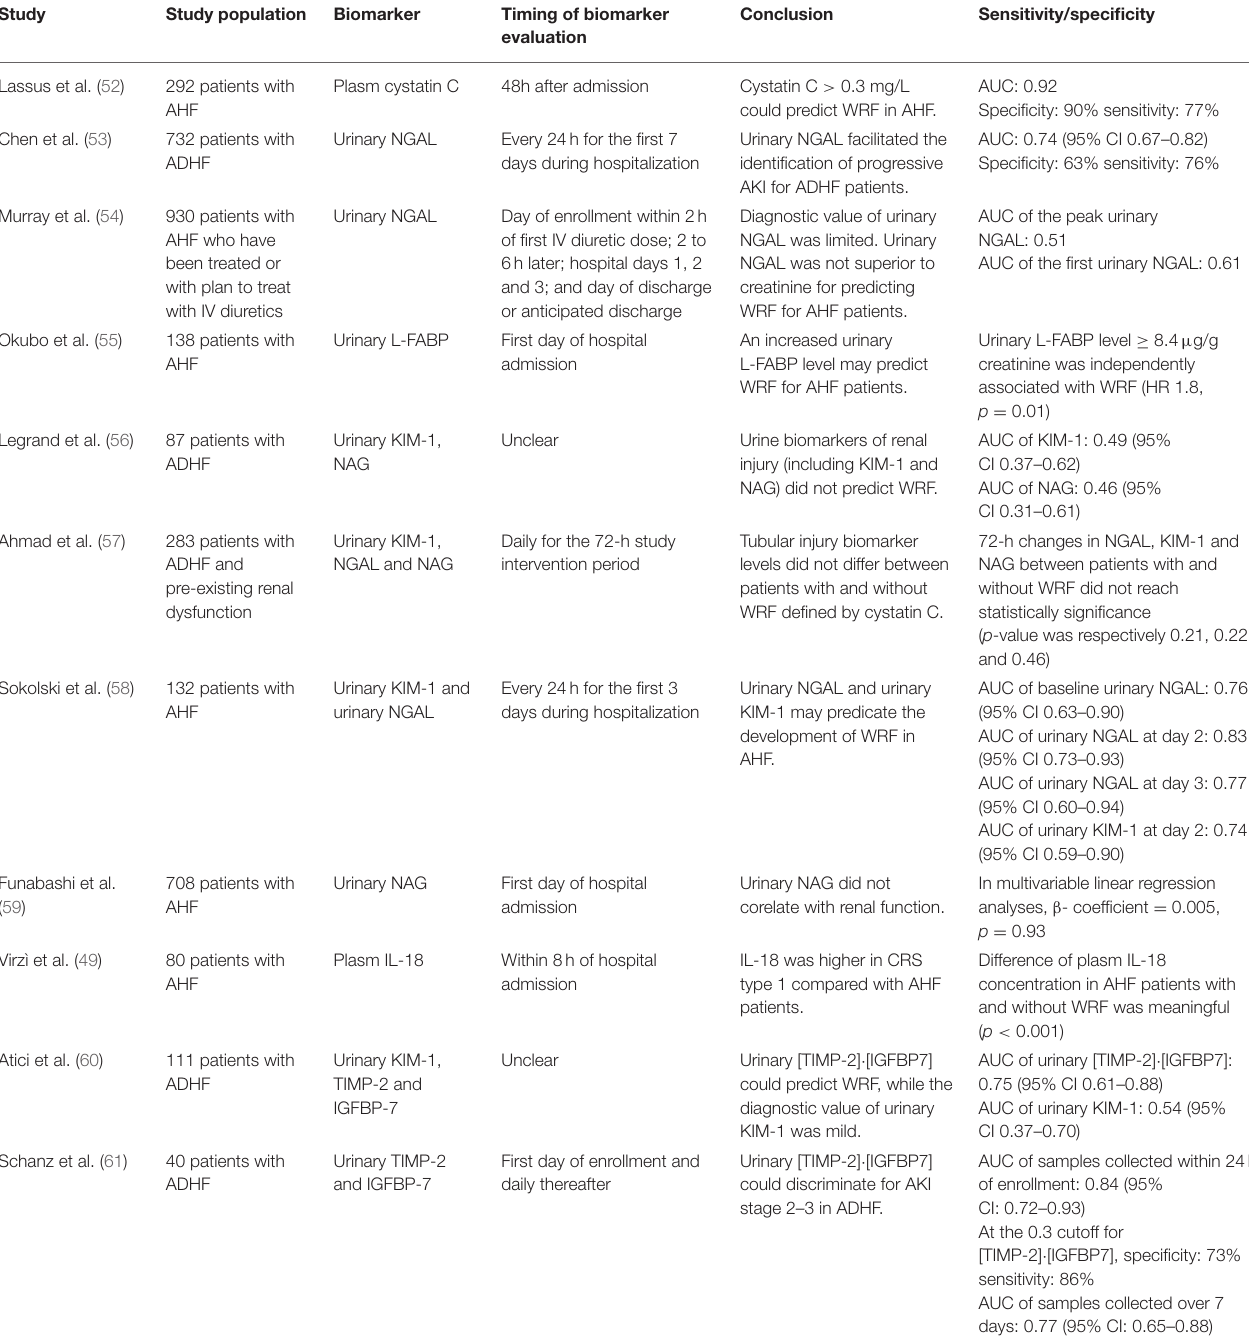
TABLE 2 | Summary of studies on biomarkers of WRF in CRS-1 in this